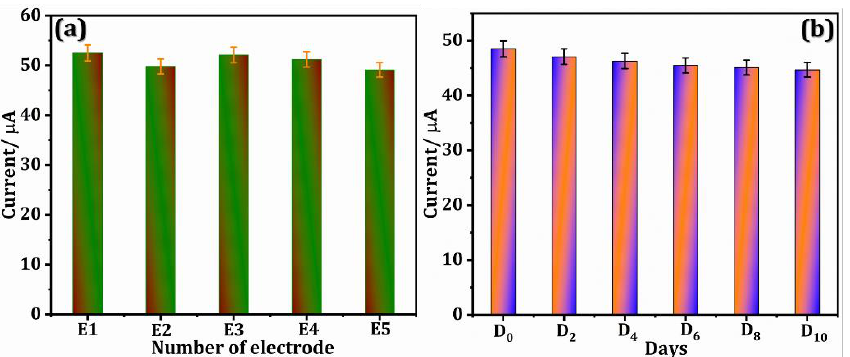
Figure 7. ( a ) Bar graphs for the reproducibility study and ( b ) storage stability of the Sr@Se/PGCN/GCE in 250 µM CAP.